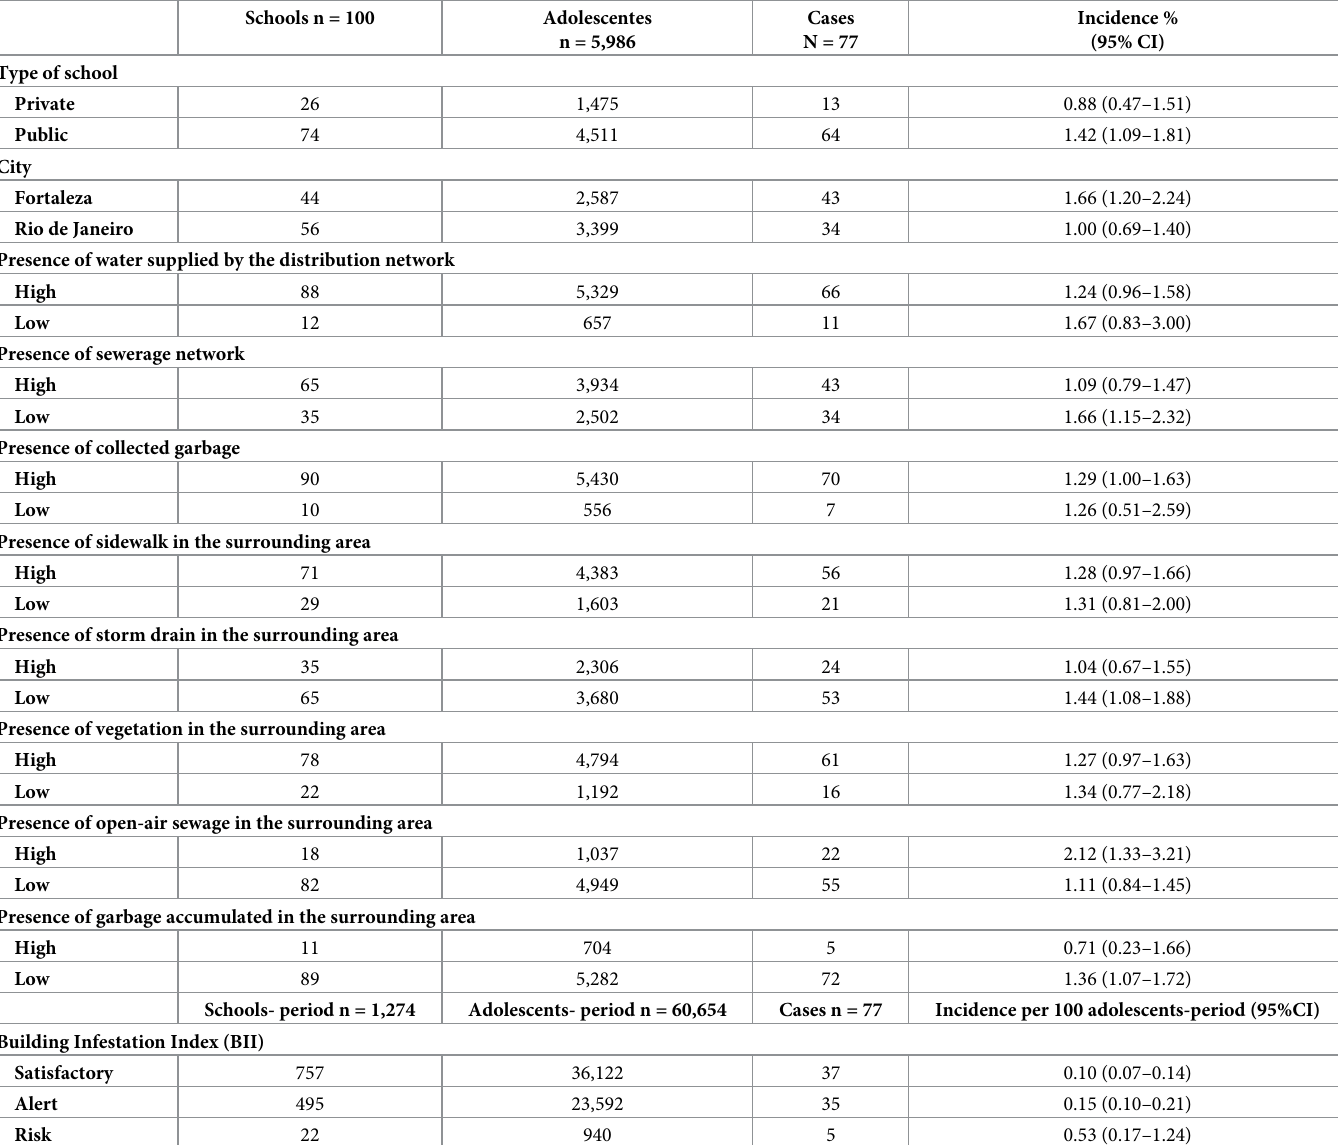
Table 2. Incidence and descriptive characteristics of the participant schools and of their surroundings—ERICA